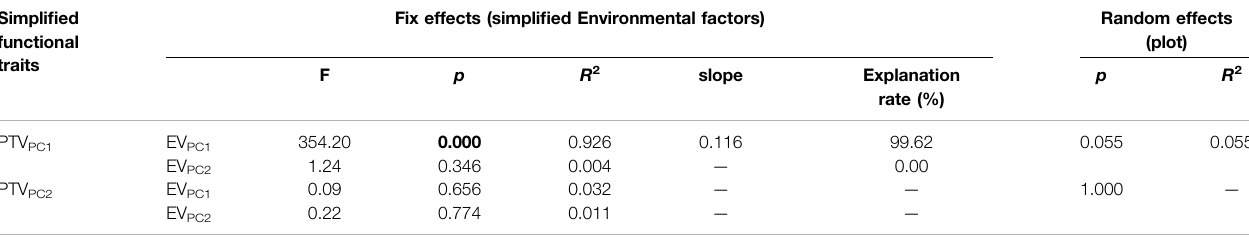
TABLE 2 | Linear mixed model results of the effects of environmental factors on functional traits of P. fruticosa. p -values less than 0.05 were marked in bold. EV PC1 , the fi rst axis of the PCA of environmental factors; EV PC2 , the second axis of the PCA of environmental factors; PTV PC1 , the fi rst axis of the PCA of functional traits; PTV PC2 , the second axis of the PCA of functional